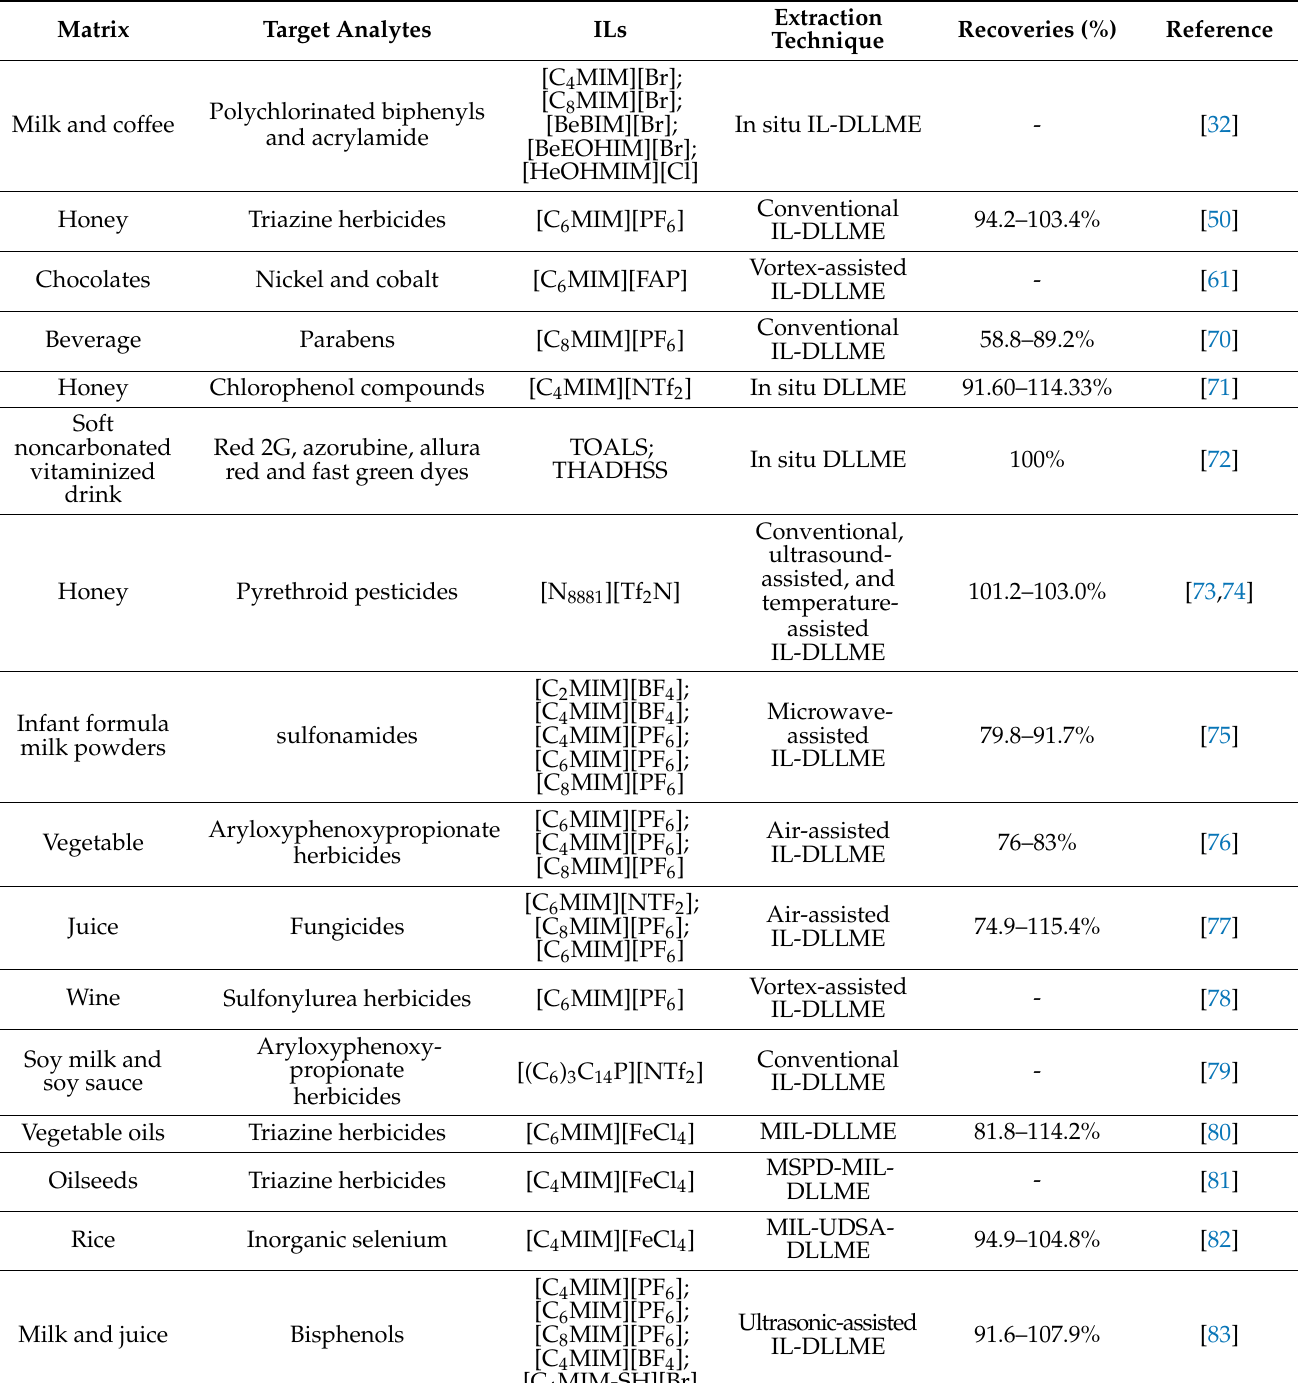
Table 1. Some representative applications of ILs in